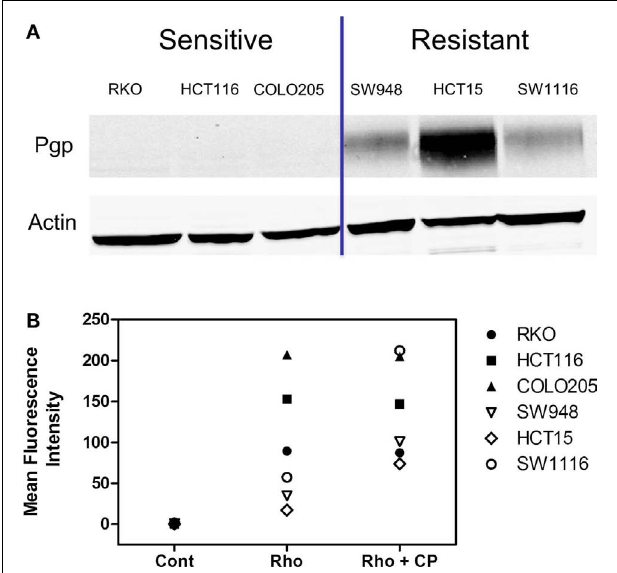
FIGURE 3 | Expression and activity of P-gp in a panel of CRC cell lines. (A) The presence of P-gp was determined in three sensitive and three resistant cell lines by western blot. Protein expression in this panel of lines corresponded to ABCB1 expression. (B) The activity of P-gp in the same panel of cell lines was verified by rhodamine uptake studies. Rhodamine (Rho) is effluxed by P-gp, so in lines with functional P-gp a lower fluorescence signal is detected. Administration of a P-gp inhibitor, CP-100356 (CP), increases the fluorescence signal in lines with function P-gp but does not affect the signal in lines without P-gp.